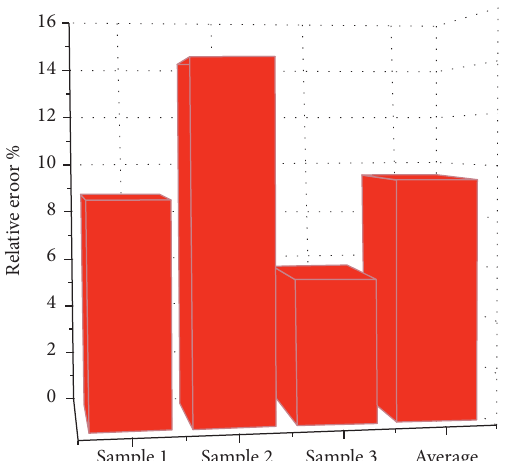
Figure 9: Relative error between measured and calculated values of